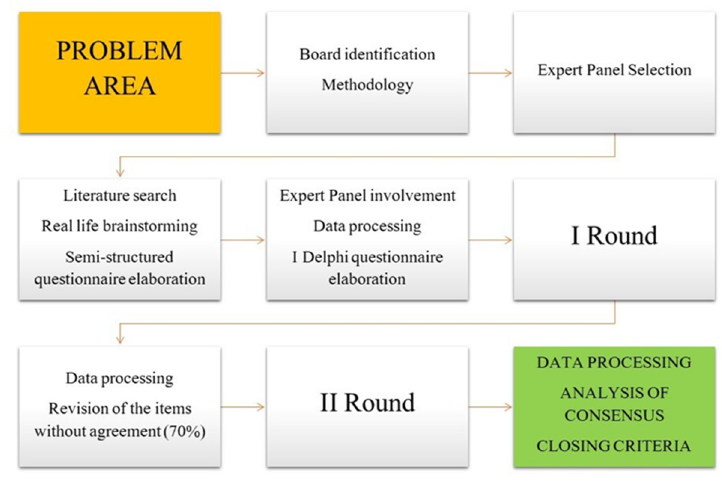
Figure 1. Flow chart of the modified Delphi survey .